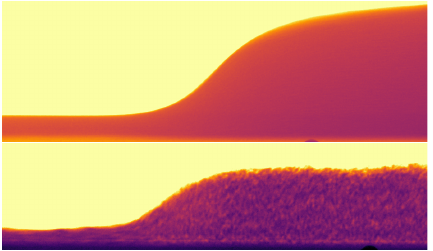
Figure 2. Examples of raw images of the jumps obtained by X- ray radiography at a given time t : glass beads for H = 35mm and ζ = 30 ◦ (top panel) and rice grains for H = 35mm and ζ = 35 ◦ (bottom panel). The particles are flowing from left to